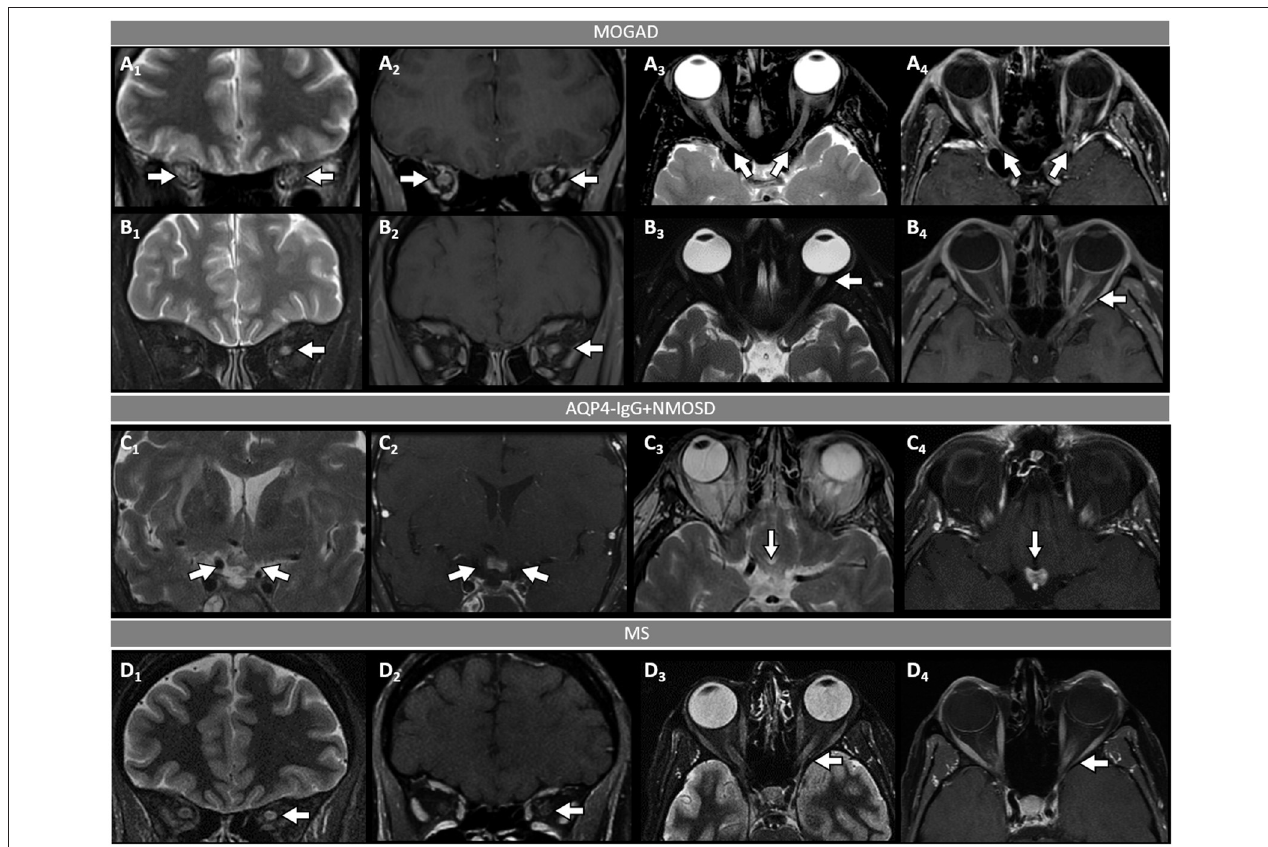
FIGURE 2 | Orbital fat-saturated MRI in optic neuritis with MOGAD, AQP4-IgG + NMOSD, and MS. [ (A,B) : MOGAD] Bilateral optic nerve sheath thickening (A 1 , coronal view, arrows) and optic nerve T2-hyperintensity (A 3 , axial view, arrows) on T2-weighted images, and corresponding longitudinally extensive optic nerve and sheath enhancement on T1-post gadolinium images (A 2 , coronal view, arrows, and A 4 , axial view, arrows). Unilateral left optic nerve T2-hyperintensity on T2-weighted images (B 1 , coronal view, arrow, and B 3 , axial view, arrow) and longitudinally extensive enhancement of the left optic nerve on T1-post-gadolinium images (B 2 , coronal view, arrow, and B 4 , axial view, arrow). [ (C) : AQP4-IgG + NMOSD] Bilateral optic chiasm T2-hyperintensity on T2-weighted images (C 1 , coronal view, arrows, and C 3 , axial view, arrow) and optic chiasm enhancement on T1-post-gadolinium images (C 2 coronal views, arrow, and C 4 , axial view, arrow). [ (D) : MS] Unilateral left optic nerve T2-hyperintensity on T2-weighted images (D 1 , coronal view, arrow, and D 3 , axial view, arrow), with a corresponding short segment of gadolinium-enhancement on T1-post-gadolinium images (D 2 , coronal view, arrow, and D 4 , axial view, arrow). MOGAD, myelin oligodendrocyte glycoprotein antibody-associated disease; AQP4-IgG + NMOSD, aquaporin-4-IgG seropositive neuromyelitis optica spectrum disorder; MS, multiple sclerosis. Definitions: Longitudinally extensive